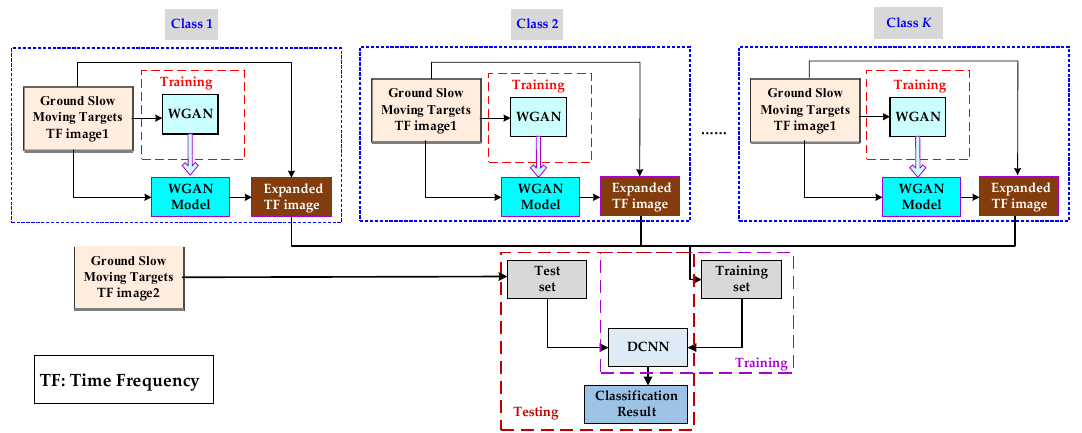
Figure 3. The flowchart of the proposed GMT ‐ WGAN classification method.